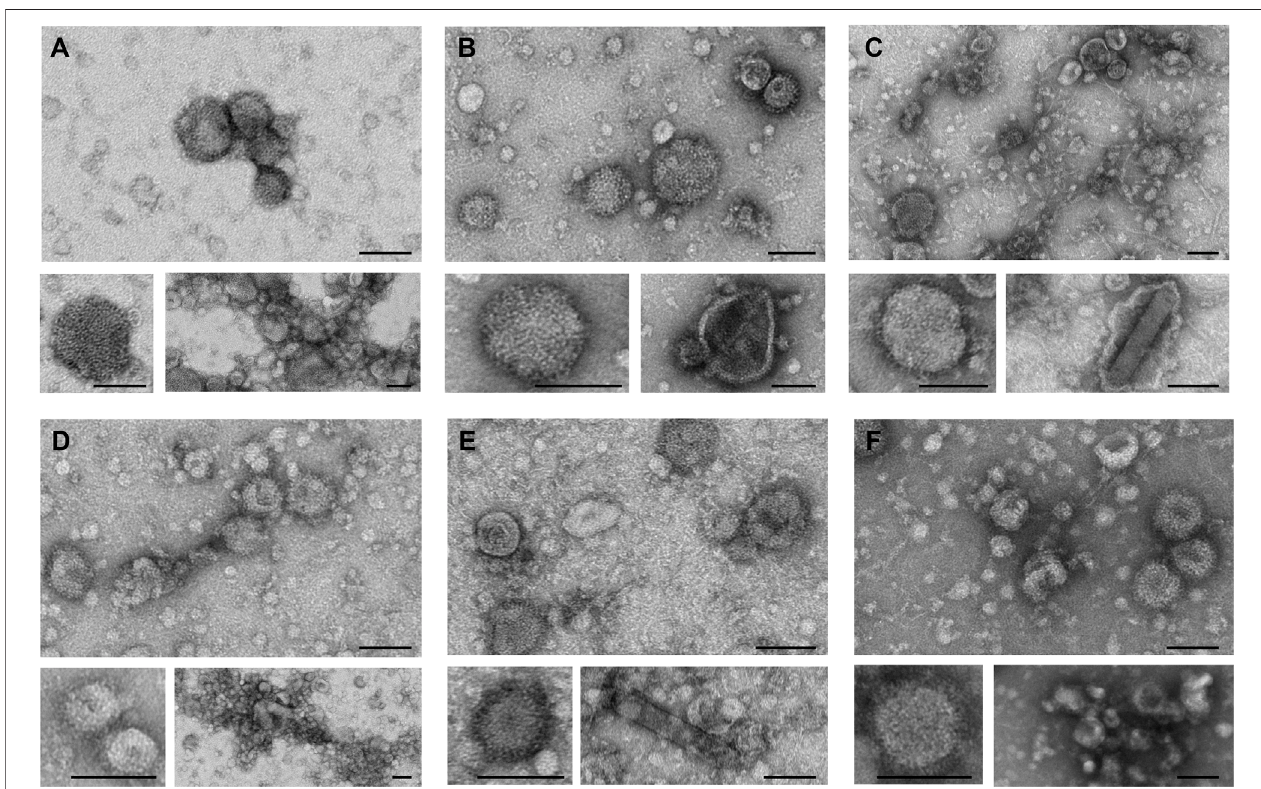
FIGURE 4 | Transmission electron microscopy of puri fi ed in fl uenza VLPs. Representative images of TEM analysis depicting VLP size and morphology of puri fi ed samples (SEC fraction selected). Top panels show an overview of the analyzed samples; bottom left panels show close up views of individual spherical VLPs presenting the characteristic in fl uenza HA spikes; bottom right panels show the presence of larger and pleomorphic VLPs, aggregates or baculovirus. (A) H1 Mono VLP, (B) H1 Penta VLP, (C) H3 Mono VLP, (D) H3 Penta VLP, (E) B Mono VLP, (F) B Penta VLP. Scale bar, 100